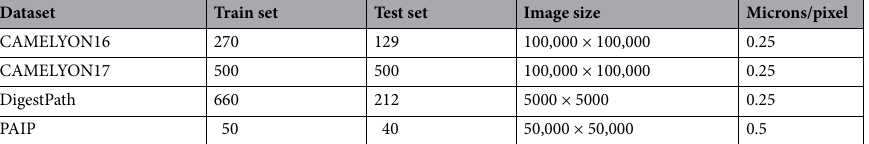
Table 1. Summary of histopathological datasets used in this work. The test images were hidden by the competition organizers and used only for leaderboard